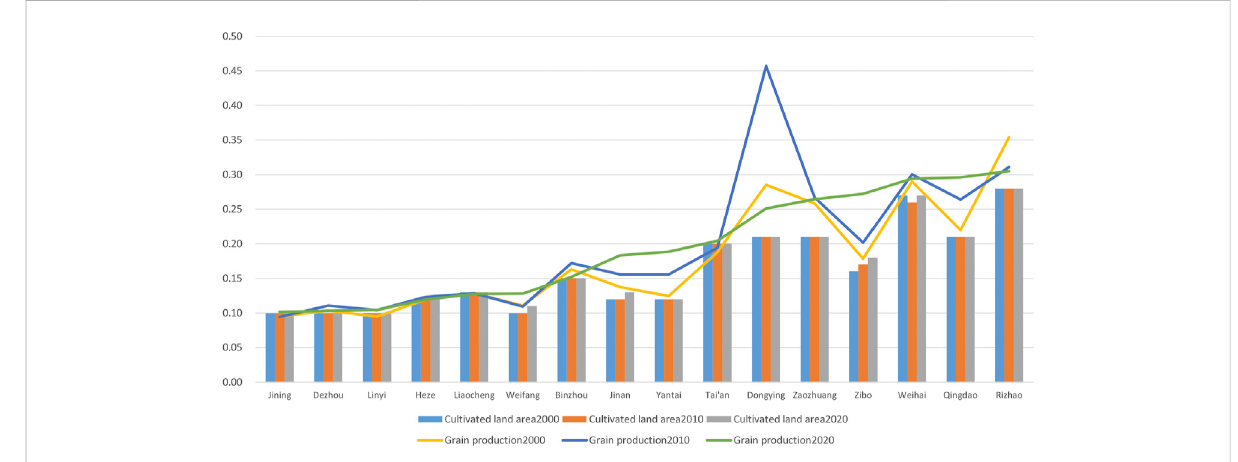
FIGURE 4 Spatial distribution concentration of cultivated land and grain production.